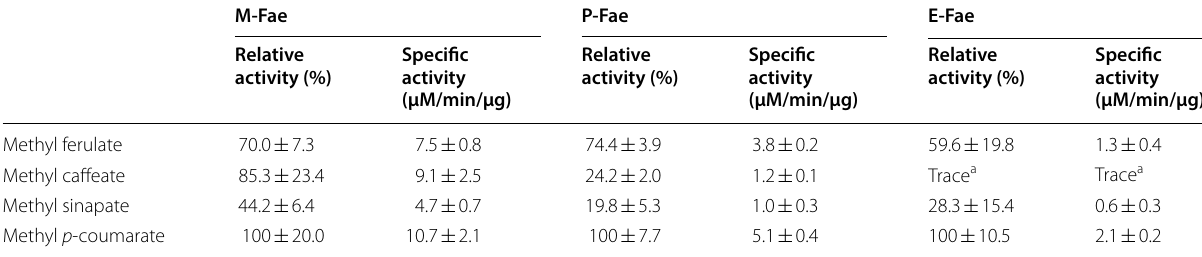
Data were obtained at 35 °C in sodium phosphate at pH 7.5 for M-Fae and E-Fae, and at pH 8.0 for P-Fae, using a stopped assay. The results given are the average of three experiments one standard deviation ± a Trace: trace activity observed (less than 0.4